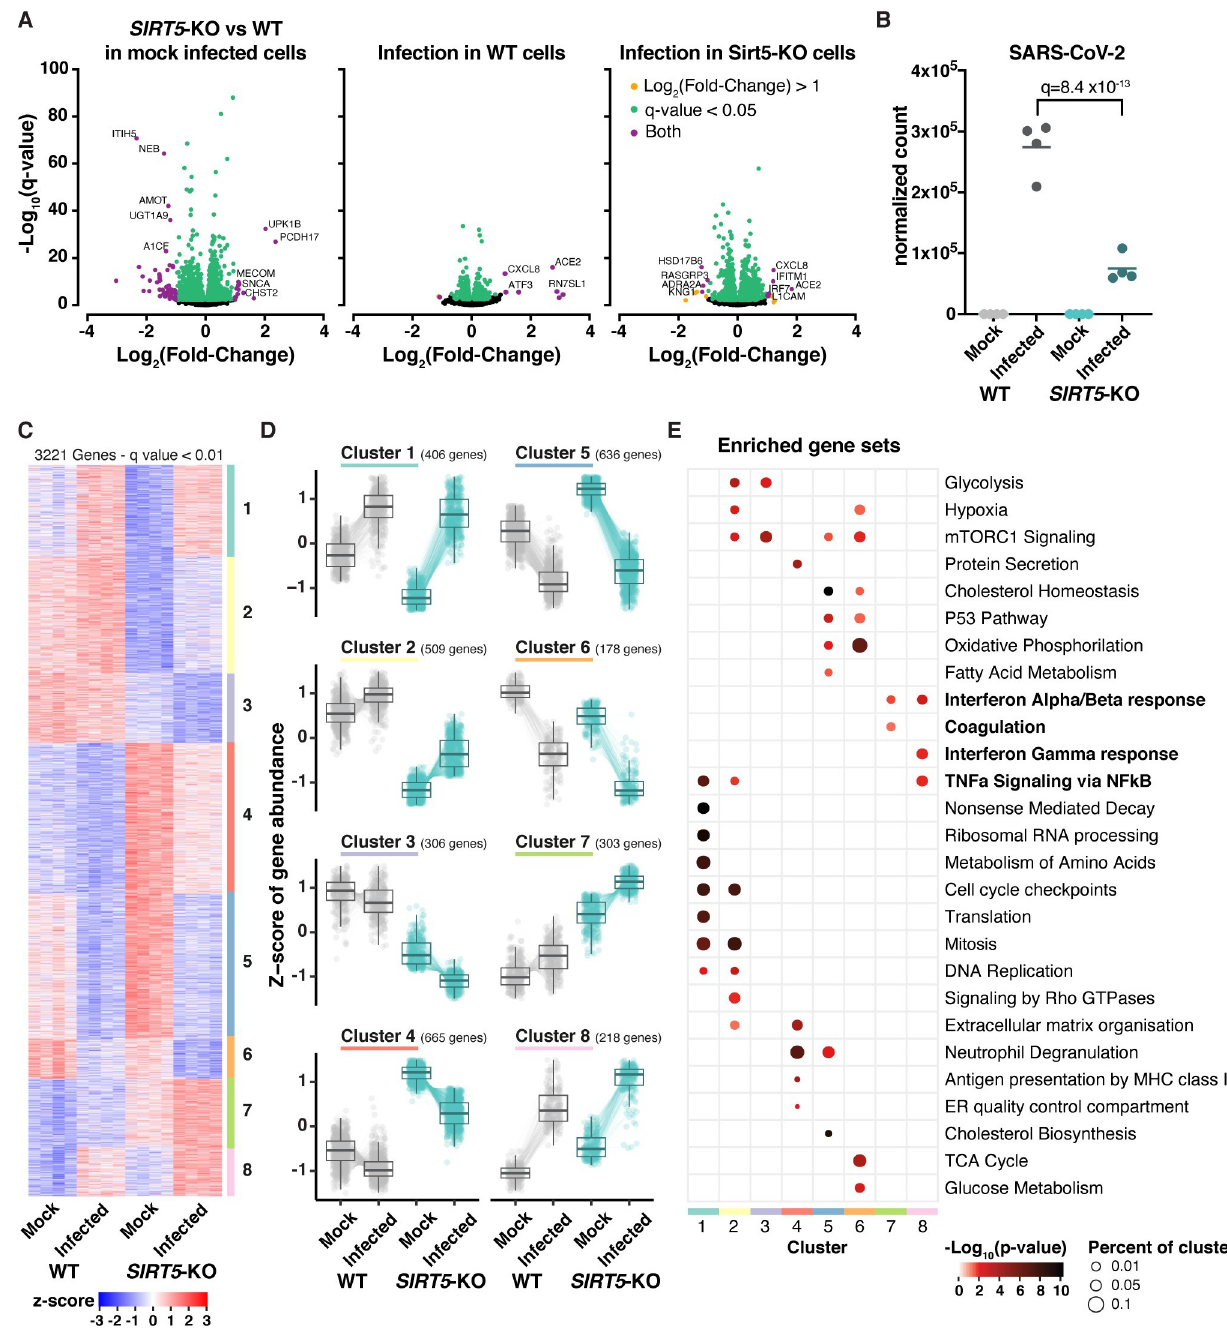
Fig 6. SIRT5 -KO cells mount a stronger innate immune response. RNA-seq analysis of WT and SIRT5- KO A549-ACE2 cells infected or mock-infected for 3 days with SARS-CoV-2 at MOI = 1. n = 4. A . Volcano plots showing differentially expressed genes between the different conditions. Highlighted genes display a q-value q < 0.05 (green), log2 fold-change > 1 (orange), or both (purple). Left panel: SIRT5 -KO vs WT in mock-infected cells. Middle: Infected vs mock-infected WT cells. Right: Infected vs mock-infected SIRT5- KO cells. B. Normalized gene count of SARS-CoV-2. C-D. Unsupervised clustering of the 3221 genes differentially expressed between at least two of the four conditions (q < 0.01). C: heatmap of normalized expression. D. Z- scores of differentially expressed genes as grouped by clustering. Colored lines represent the quantification of an individual gene whereas solid black lines show the cluster Tukey boxplot. E. Enrichment analysis of biological gene sets in the identified gene clusters (C and D).